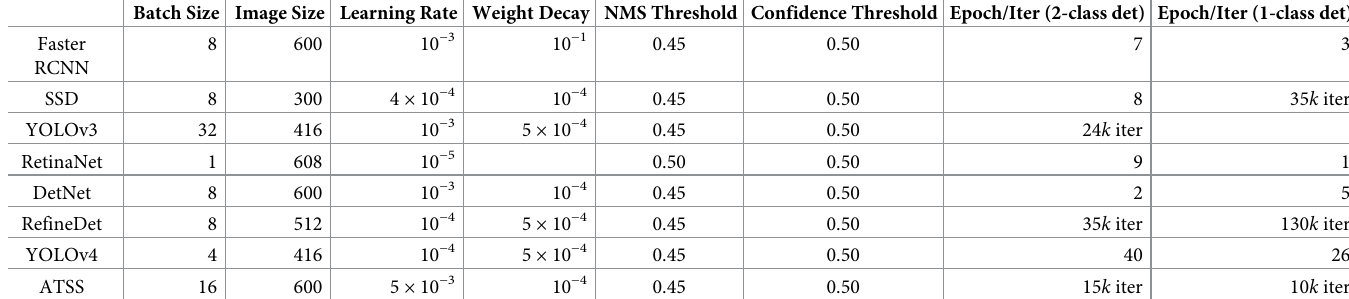
Table 2. Experiment